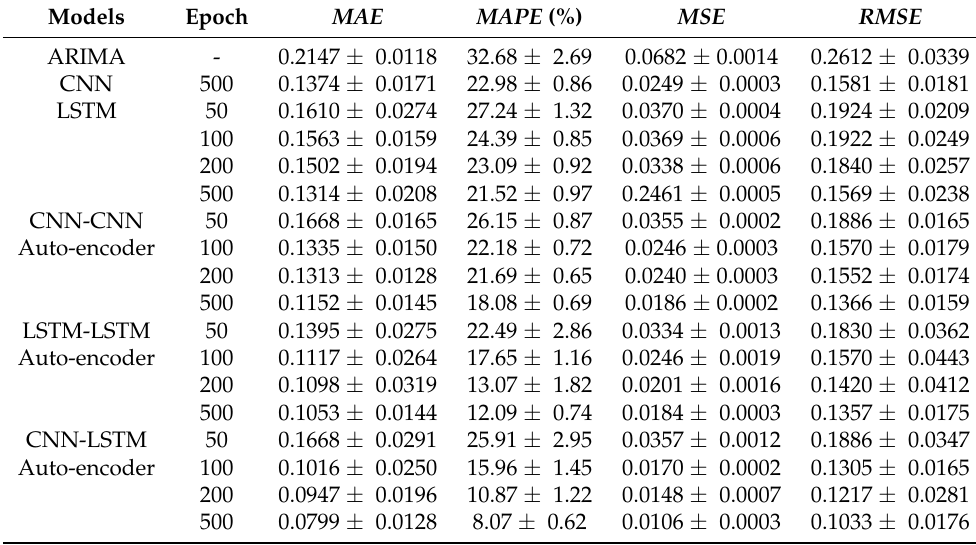
Table 2. Comparison among different forecasting